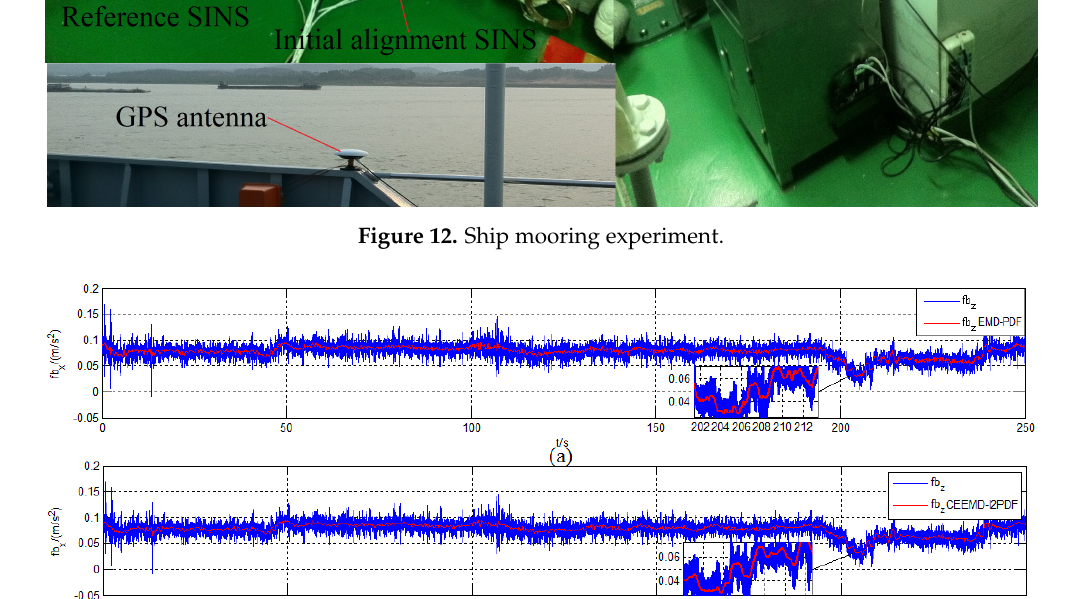
Figure 13. Denoising results of ˜ f b ( b ) CEEMD- l 2 PDF